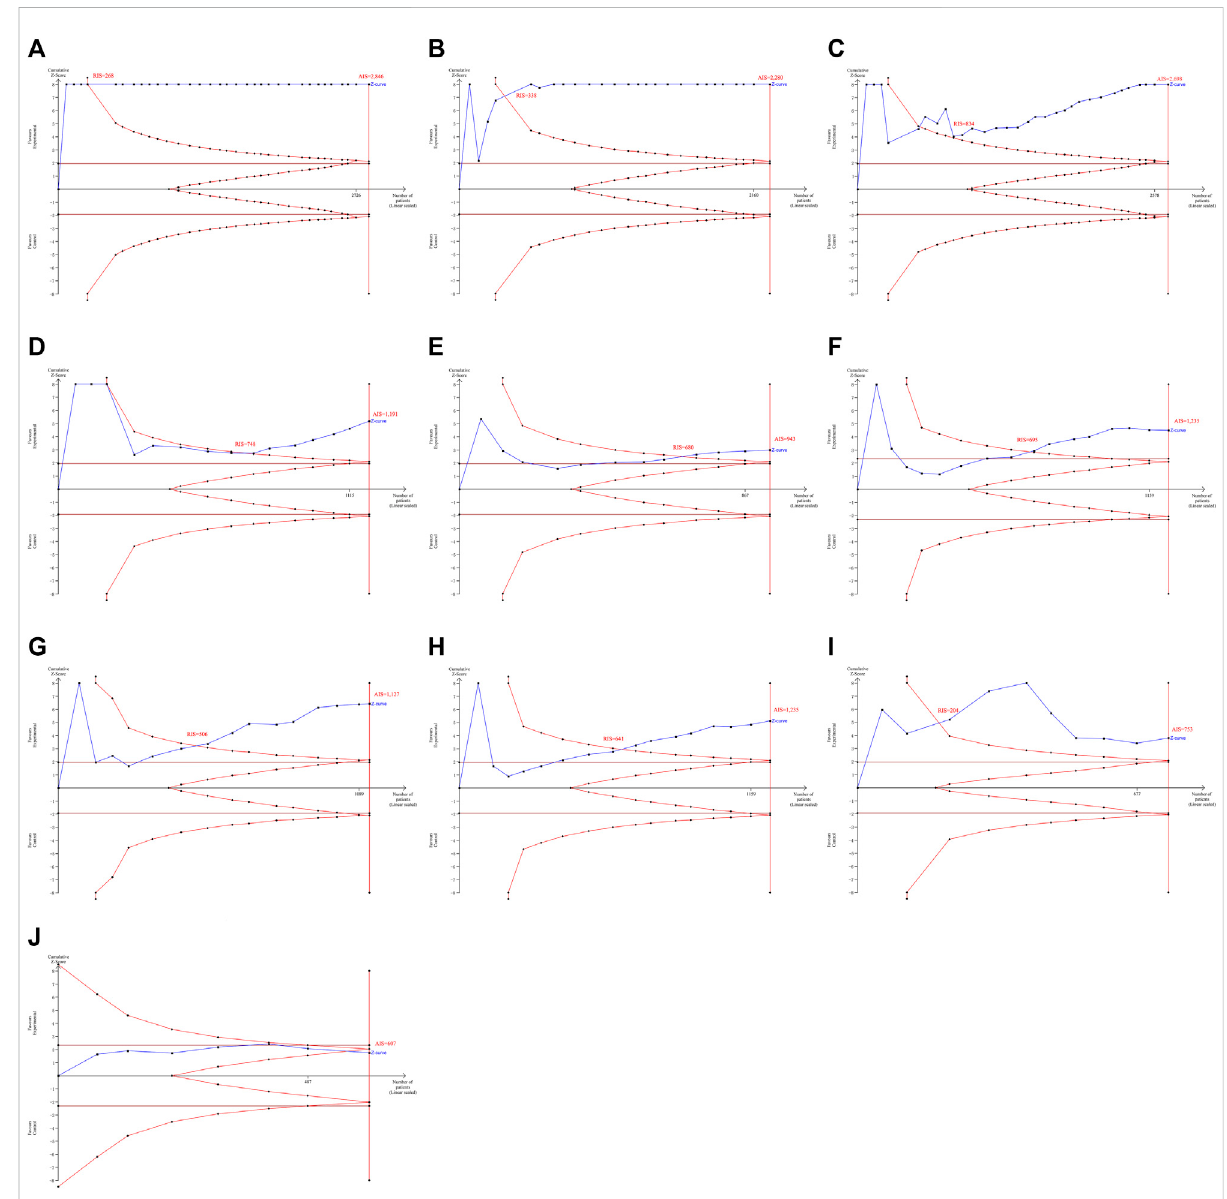
FIGURE 3 TSA analysis for the effectiveness of HLPs in improving T2DM. Note: (A) Represents FBG; (B) Represents 2hPG; (C) Represents HbA1c; (D) Represents FINS; (E) Represents HOMA-IR; (F) Represents TC; (G) Represents TG; (H) Represents LDL-c; (I) Represents HDL-c; (J) Represents